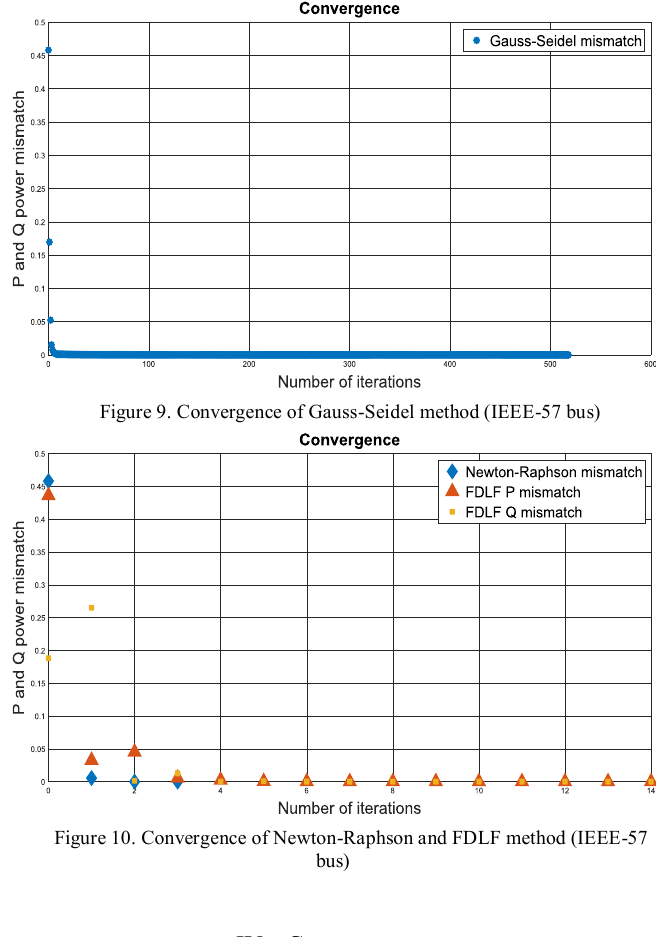
Figure 10. Convergence of Newton-Raphson and FDLF method (IEEE-57